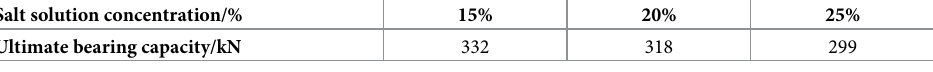
Table 8. Ultimate bearing capacity of specimens strengthened with SMA in different concentrations of salt